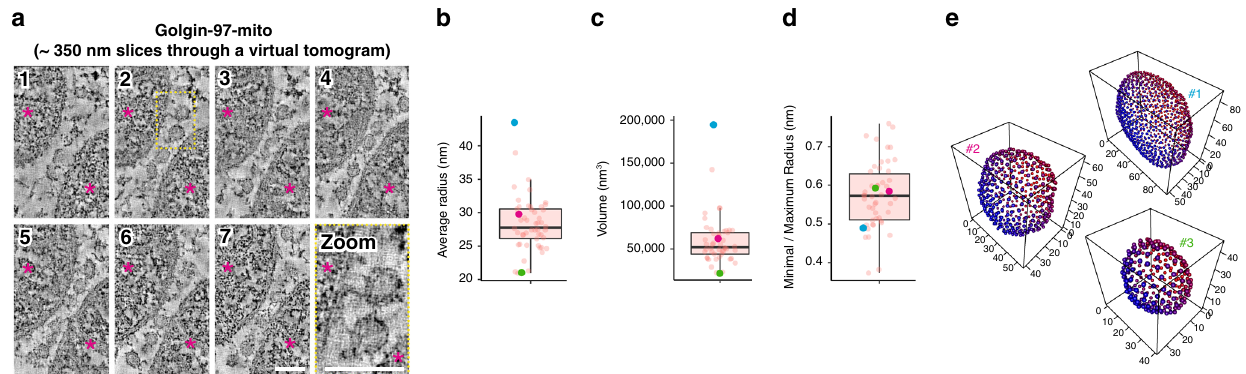
Fig. 4 Electron tomography of vesicles captured by golgin-97-mito. a CLEM of a Lowicryl-embedded HeLa cell expressing golgin-97-mito and TMEM87A-RFP throughout a thickness of approximately 350 nm. Mitochondria are large dense structures (pink stars) sandwiching small circular structures. Images are representative of two independent experiments. Scale bars 100 nm. b – d Boxplots showing quantitation of spherical structures in a through 3D segmentation using LimeSeg (50 quanti fi ed structures over two independent tomograms, data provided in the Source Data fi le), boxplots as for Fig. 1g. e 3D projections of indicated quanti fi ed structures in b – d , scale in nm. Data are provided as a Source Data fi